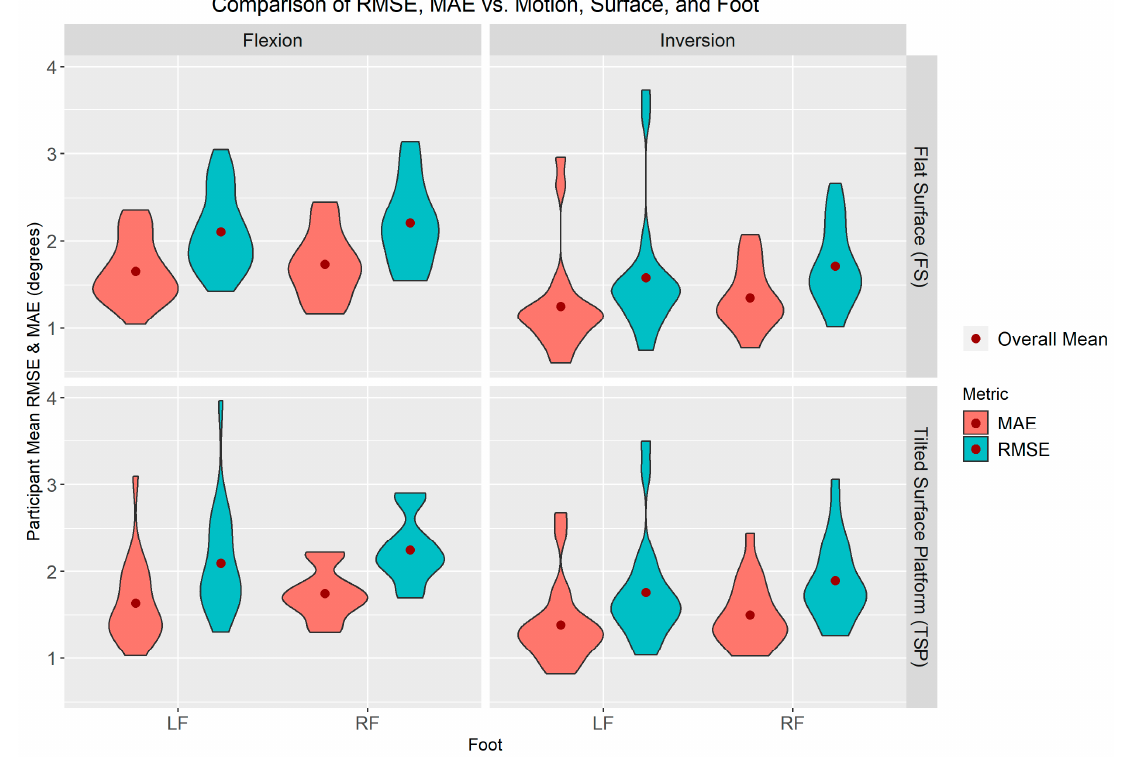
Figure 7. Violin plot of root mean square error (RMSE) and mean absolute error (MAE) metric showing the mean and spread of results with respect to various factors. Flexion and inversion columns represent the motion that was being predicted. Rows represent the two types of surfaces the participant walked on. Left foot and right foot sensors are represented in the graph as LF and RF, respectively.